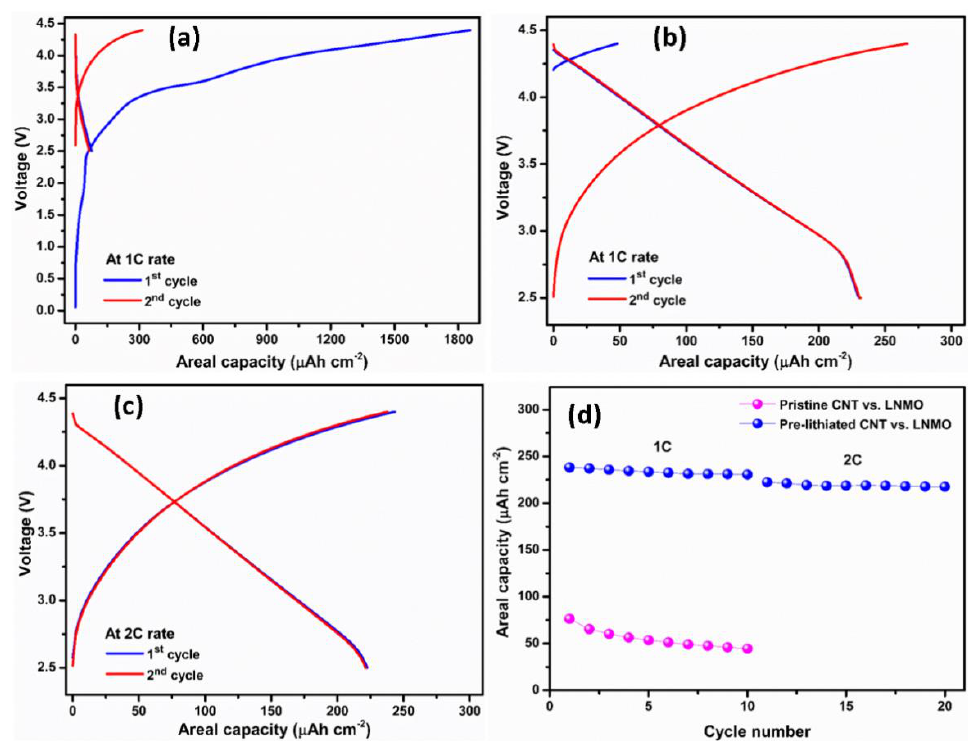
Figure 8. Typical galvanostatic charge–discharge potential profiles for the 1st and 2nd cycle at 1 C rate for ( a ) pristine CNT–LNMO, ( b ) pre-lithiated CNT-LNMO, ( c ) galvanostatic charge–discharge profiles of pre-lithiated CNT–LNMO at 2 C rate, ( d ) cycling performance of the pristine and